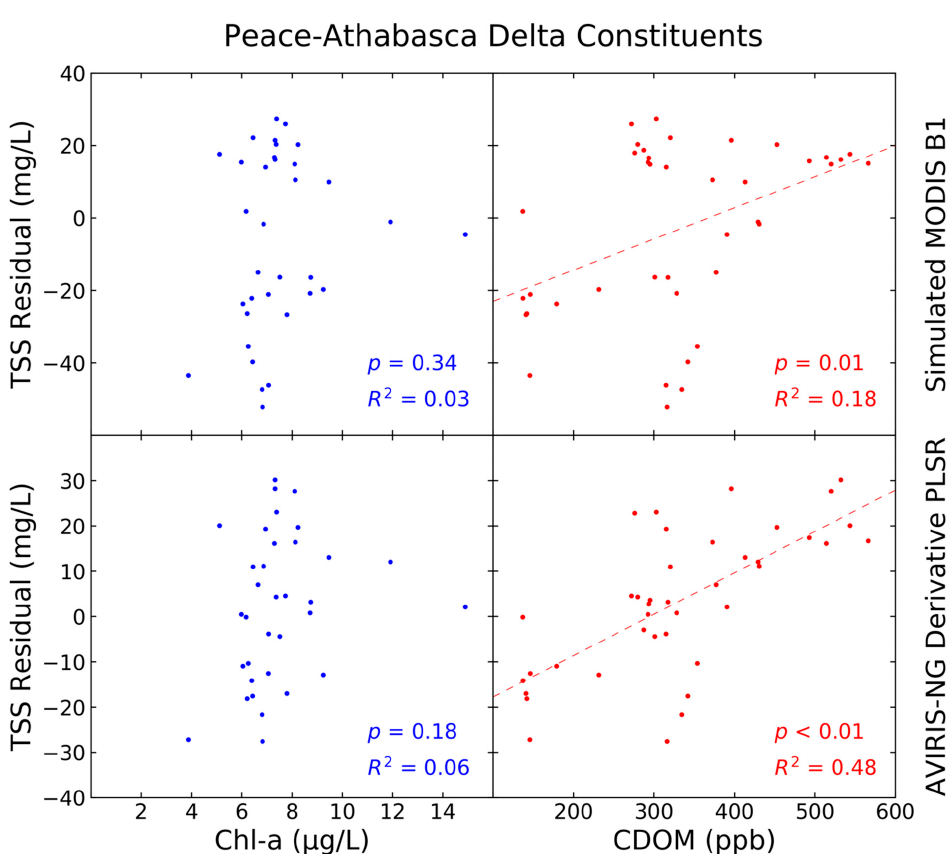
Figure A4. Statistical relationships between the predicted TSS residuals and other water constituents from corresponding water samples in the Peace–Athabasca Delta. These include chlorophyll a (left) and CDOM (right) concentrations for both the simulated MODIS B1 model (top) and the AVIRIS-NG derivative-based PLSR model (bottom). CDOM is listed in parts per billion of a standard solution used to calibrate the fluorescence probe. Regression lines are plotted for relationships that are significant at a p < 0.05 level.